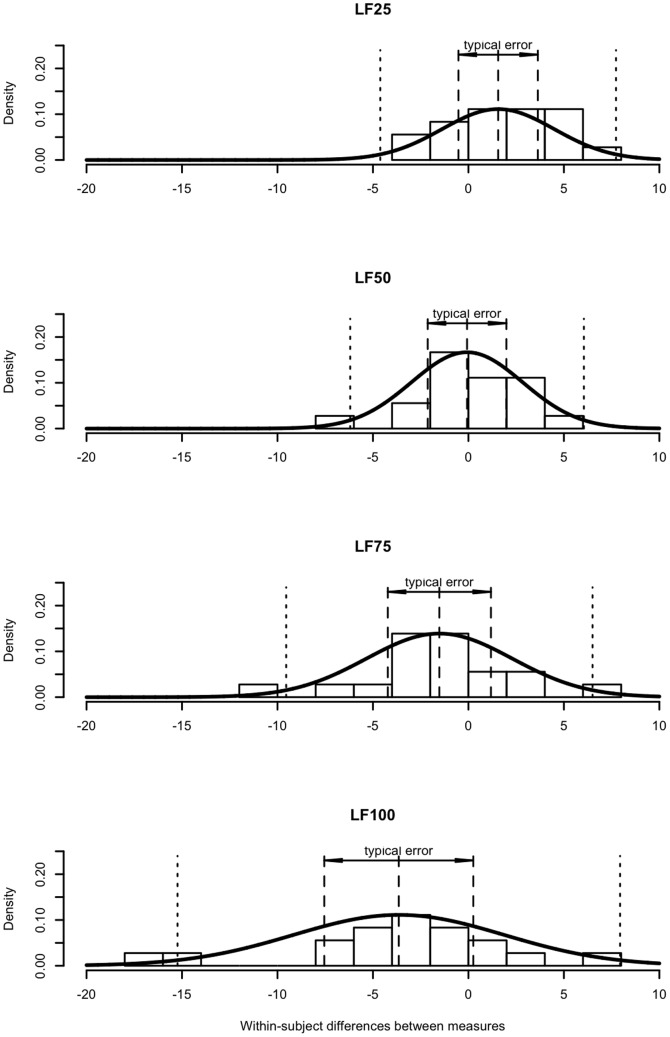
Systematic difference and random variance between the modified Oxford gain and the transfer function moduli.Systematic difference and random variance between modified Oxford baroreflex gain and the transfer function modulus calculated from the different segment of the low-frequency range. LF25, LF50, LF75 denote the segments in which the transfer function modulus was calculated for the analysis. LF100 denotes the entire low-frequency range between 0.04–0.15 Hz. Dashed lines represent mean difference and typical error. Dotted lines represent limit of agreement.